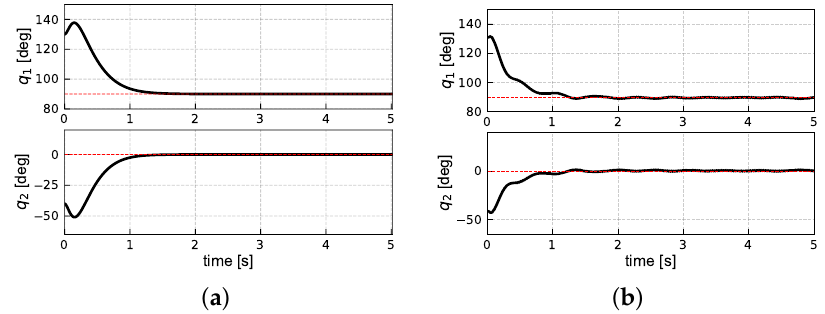
Figure 15. Case C2: Angular positions: ( a ) simulation, ( b ) experiment.